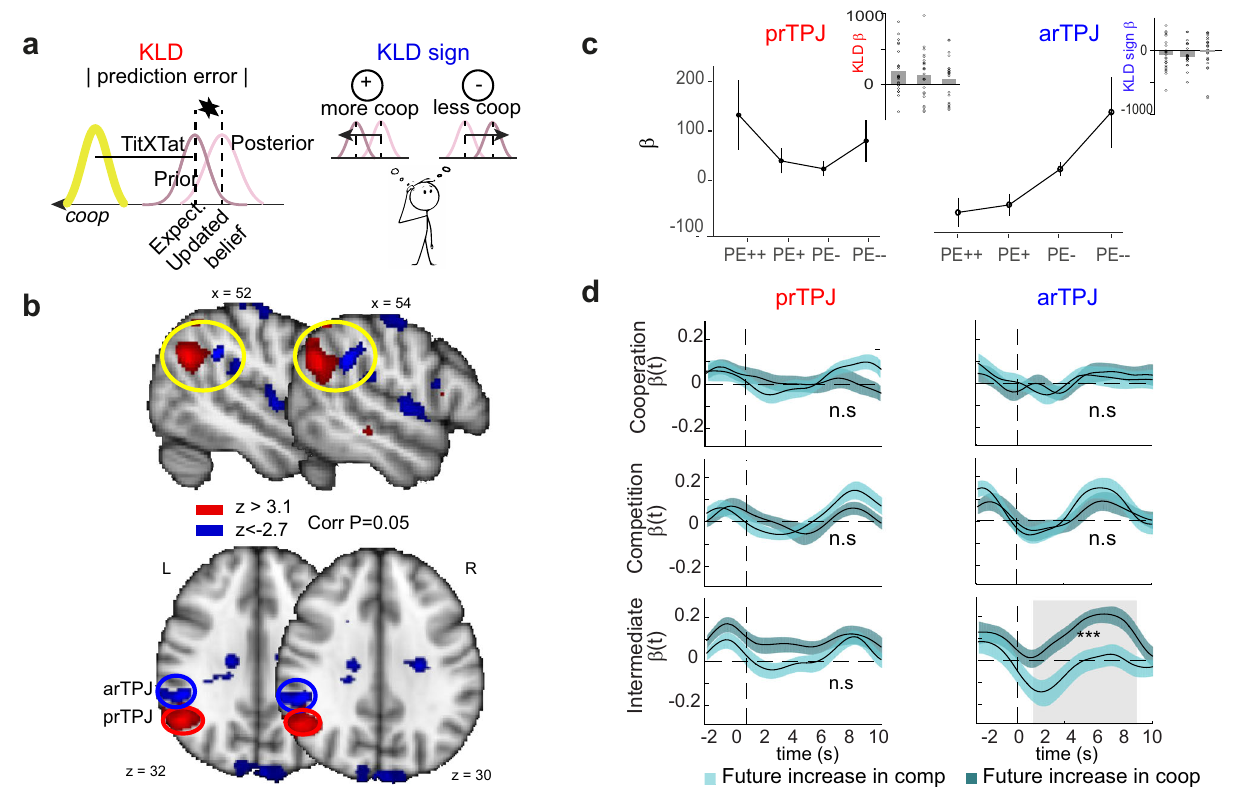
Fig.4|TheTPJencodesalldimensionsofasocialpredictionerrorandpredicts futurebehaviour.aLeftpanel: ThemagnitudeoftheKLDrepresentstheabsolute prediction error and this is to what extent P2 position deviated from what was expected. This is a learning signal informing how much the P1 needs to adjust his positiononthenexttrial. Rightpanel: ThesignoftheKLDrepresentsthedirection of the violation of expectation: was P2 more cooperative than expected or more competitive? b One whole-brain analysis parametrically tested for voxels where activity correlated with the trial-by-trialestimates of (i)the KLD magnitude(in red) and(ii)theKLDsign(inblue). c Average(+/ − SEM)population β sforGLM3inprTPJ (left) and arTPJ (right) across four groups of trials binned based on their value of